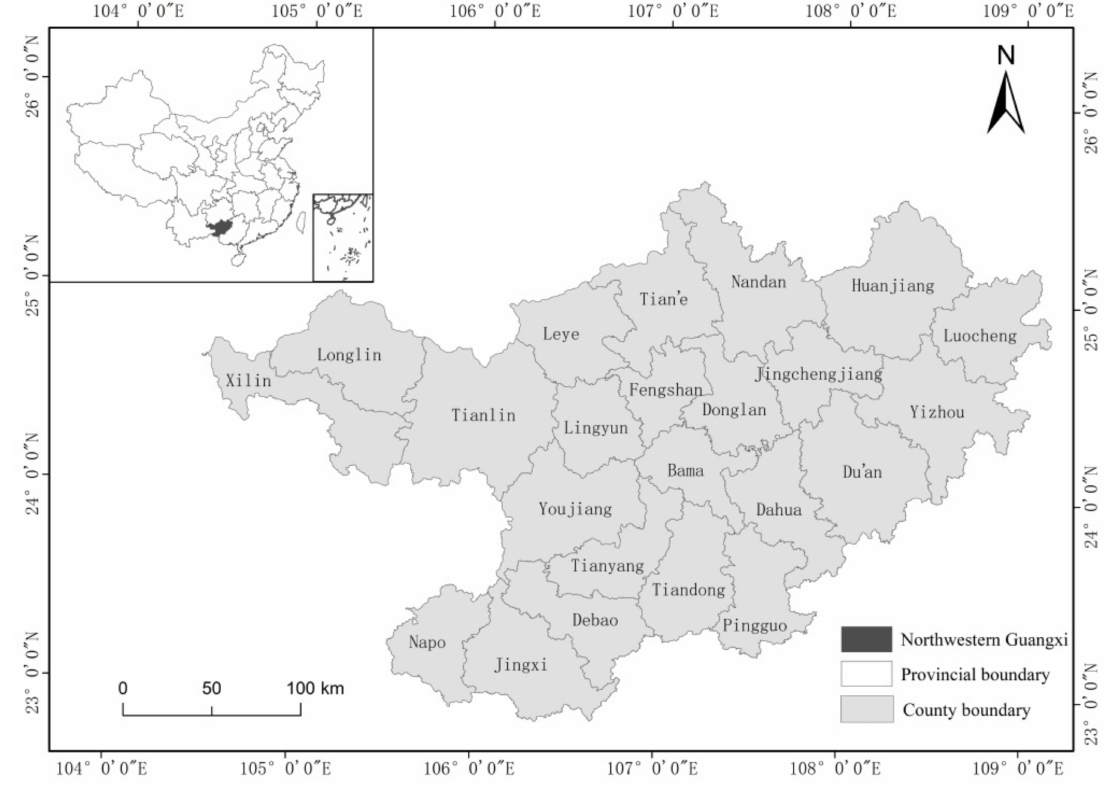
Figure 1. Administrative division map of the research area, which includes 21